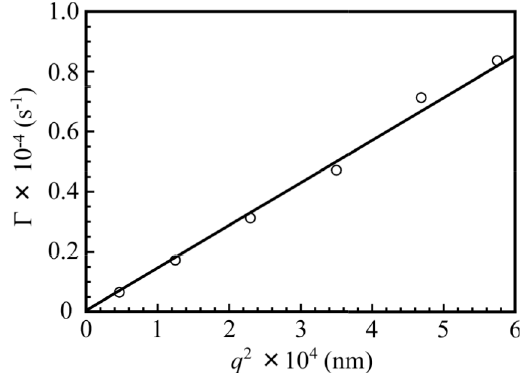
Figure 5. The relaxation rate ( Γ ) plotted as a function of the square of the magnitude of the scattering vector ( q 2 ) for the PNaSS 58 – b – PAA 125 /PNaSS 58 – b –PNIPAM 115 complex at C p = 4.4 g/L in 0.1 M NaCl at pH 3.